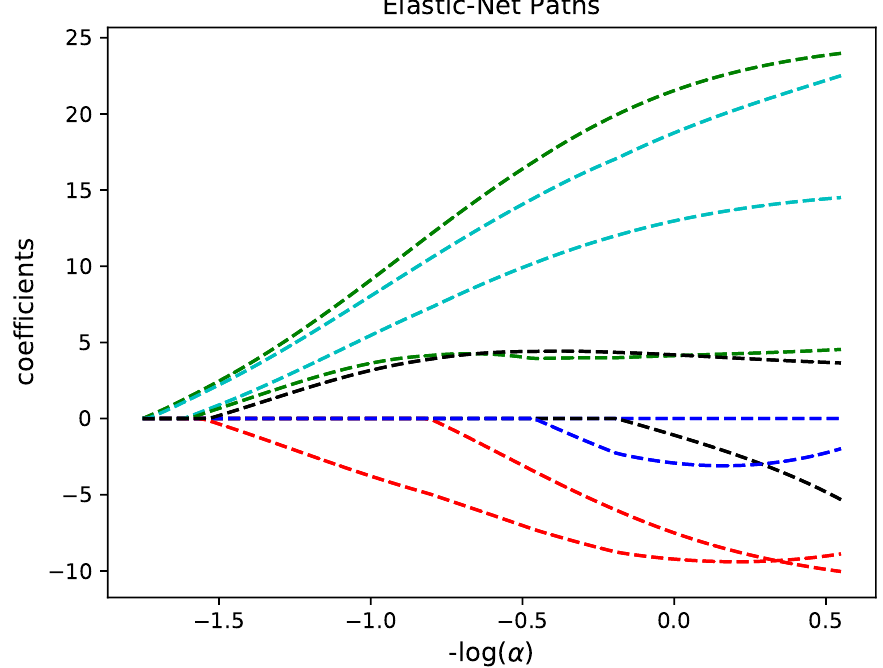
Figure 1. Regularization path for elastic net by varying α on diabetic data set illustrated in [44]. Each line traces the coefficient value of basis functions (features). As α tends to 0, more bases are added to explain data and finally resulting in ordinary LS